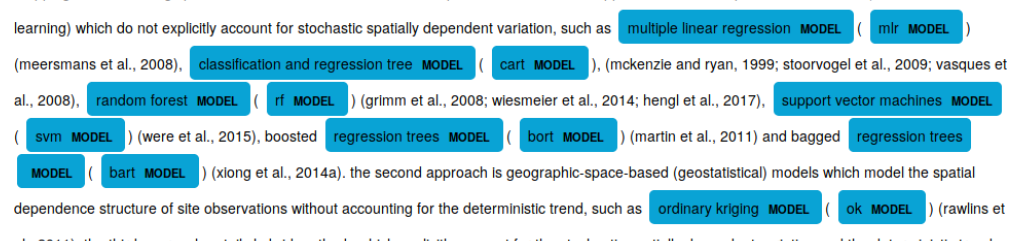
Figure 2. Excerpt from one of the reviewed articles showing named entities recognised as models. Note that the word “bagged” is not recognised, but the abbreviation “bart” is.